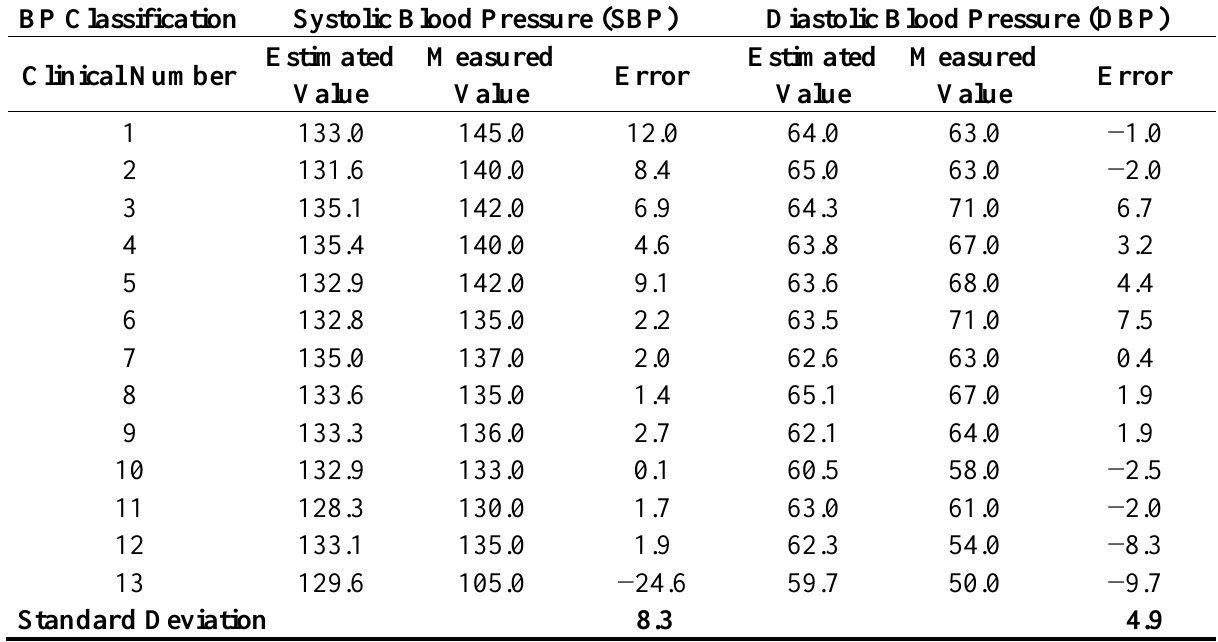
Table 1. Comparison of the measured value and the estimated value of BP applied to the clinical